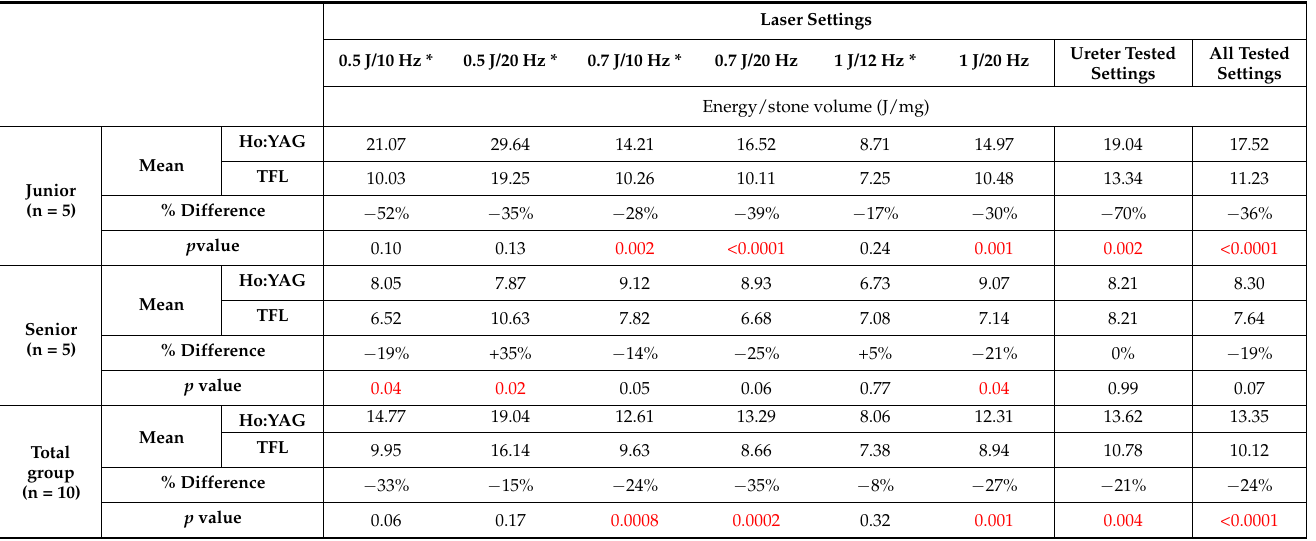
Table 2. Comparison thulium fiber laser vs Holmium:YAG. Energy/stone weight (J/mg) in each scenario after 3 min of laser lithotripsy. Holmium YAG (Ho:YAG). Thulium fiber laser (TFL).